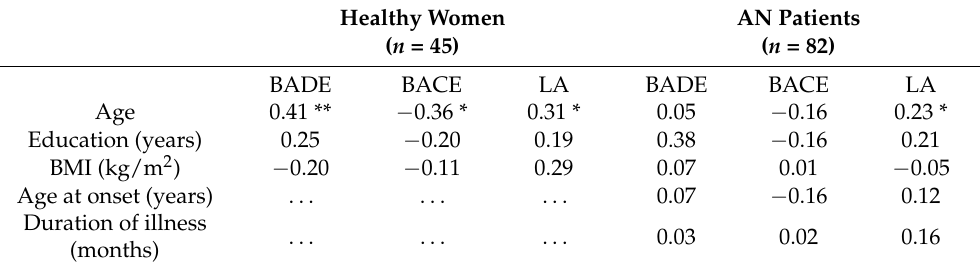
Table 4. Correlations between BADE scores and clinical variables in health women and acute AN.